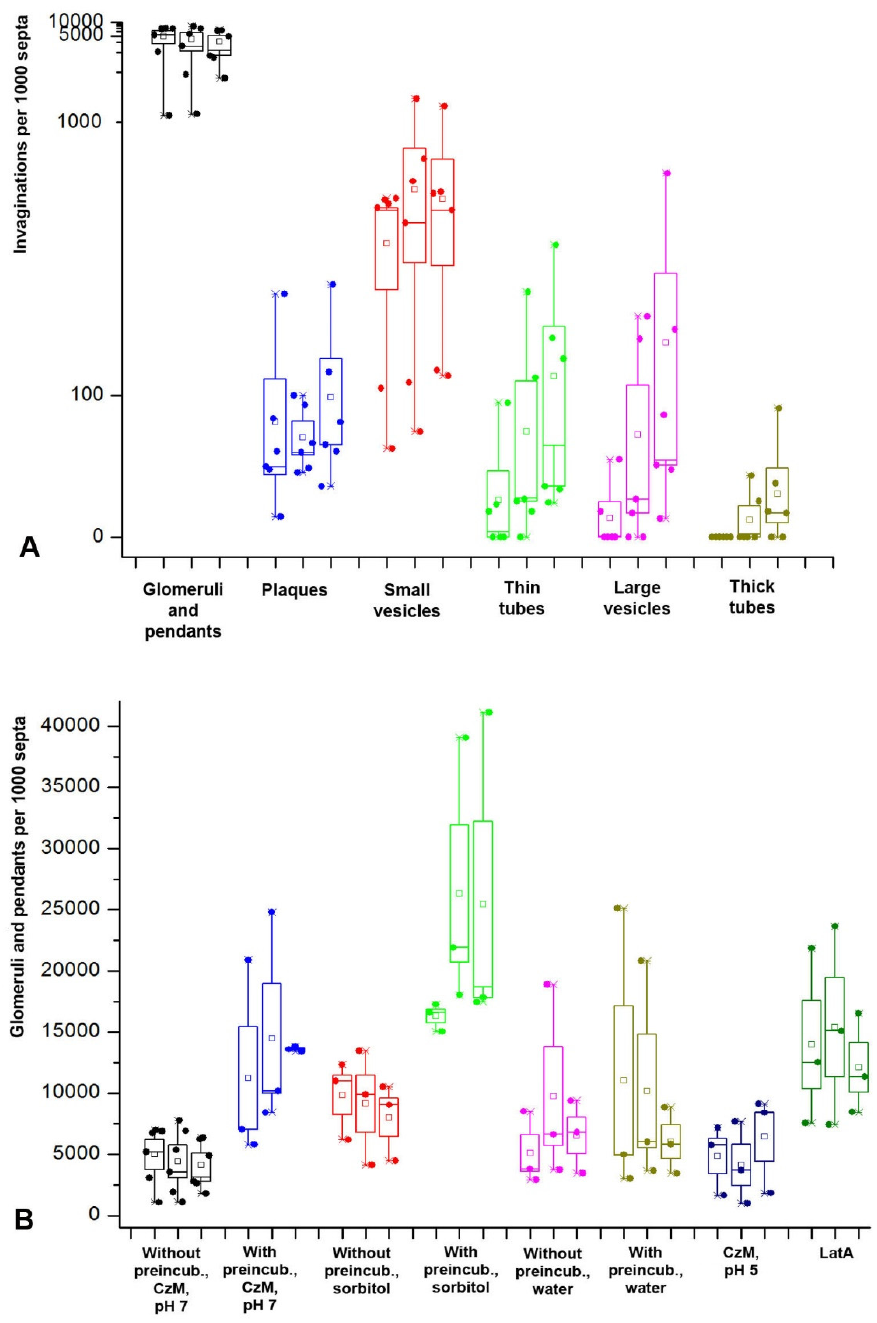
Figure 3. Diagrams showing the quantitative representation of different types of PM macroinvagi- nations in S. hirsutum . The diagram of each treatment variant or type of invagination consists of three subdiagrams—they correspond to the observation time intervals (5–15 min, 15–30 min, and 30–45 min). Each point on the diagram corresponds to the number of macroinvaginations observed in one biological experiment, calculated per 1000 septa. ( A )—all types of macroinvaginations in the basic variant of treatment (without preincubation, CzM, pH 7). The Y-axis scale is non-linear. ( B )— diagrams showing the number of glomeruli and pendants formed with different variants of sample treatment. Legend: small square—mean; box—50% standard deviation, the whisker–min/max.